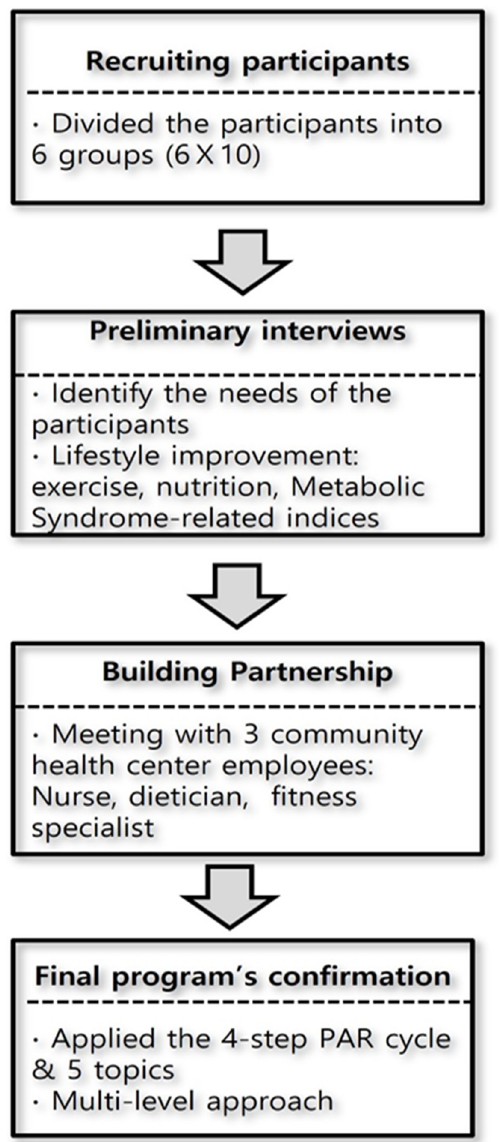
Figure 1. Flow chart of the process of the PAR intervention program’s development.